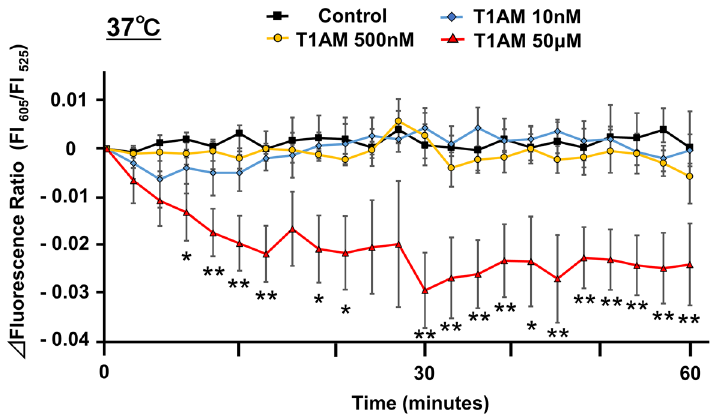
Figure 2. The profile of the thermoprobe-measured temperature change in NRCM incubated with T1AM at 37 °C. The thermoprobe-measured temperature was indicated by the Δfluorescence ratio (605 nm/525 nm). The changes of the fluorescence ratio after treatment with or without T1AM (10 nM, n = 5; 500 nM, n = 5; 50 μM, n = 5; Control, n = 6) were recorded every 2 min for the first 15 min and every 3 min for the remaining 45 min. * P < 0.05 and ** P < 0.01 versus the controls at each time point.